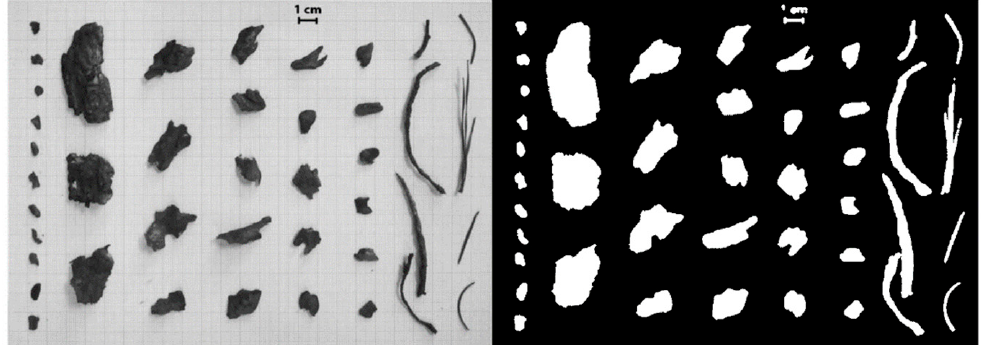
Figure 5. Image of different sizes and shapes of firebrands collected in El Houssami et al. [10] ( left ), and a greyscale conversion by MATLAB ( right ). Barks, twigs, and needles were collected as firebrands in this experiment.